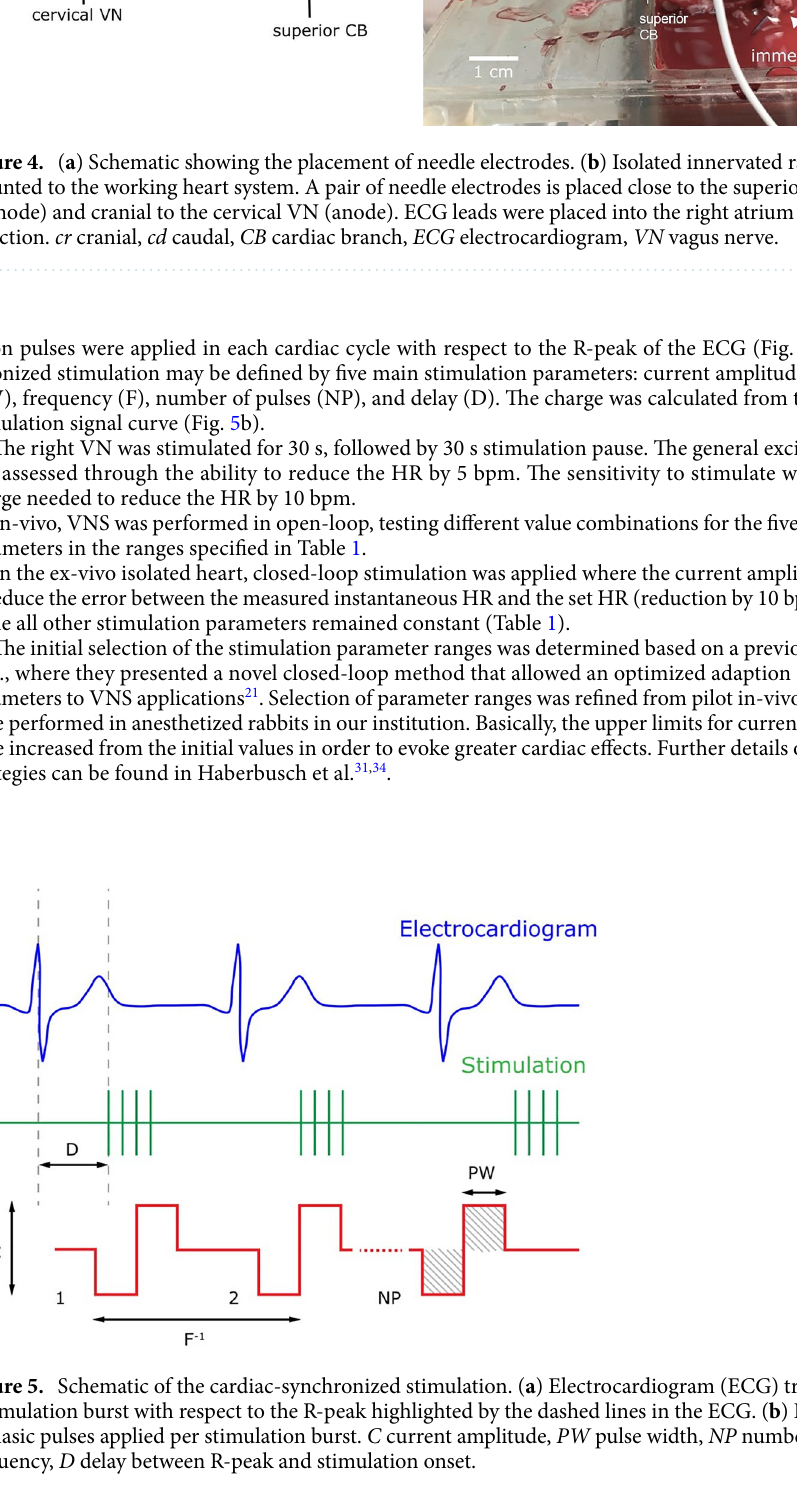
Figure 5. Schematic of the cardiac-synchronized stimulation. ( a ) Electrocardiogram (ECG) trace along with a stimulation burst with respect to the R-peak highlighted by the dashed lines in the ECG. ( b ) Detailed view of biphasic pulses applied per stimulation burst. C current amplitude, PW pulse width, NP number of pulses, F frequency, D delay between R-peak and stimulation